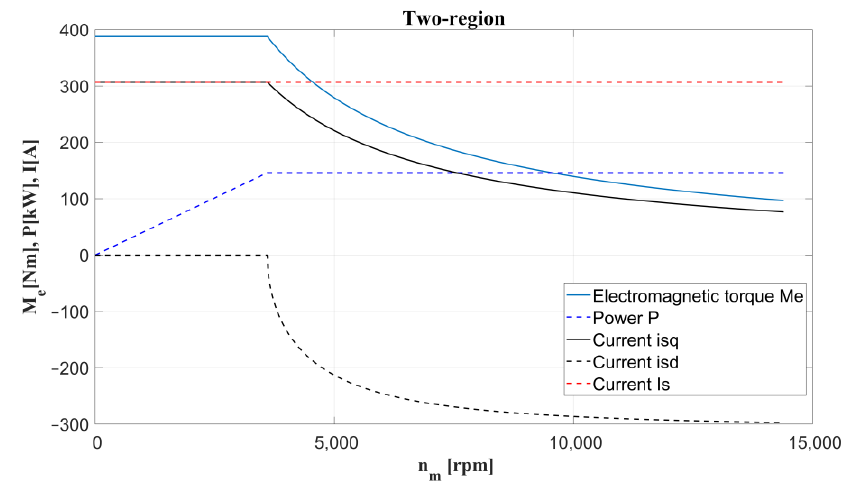
Figure 2. Ideal characteristics for the two-region control of an SMPMSM.